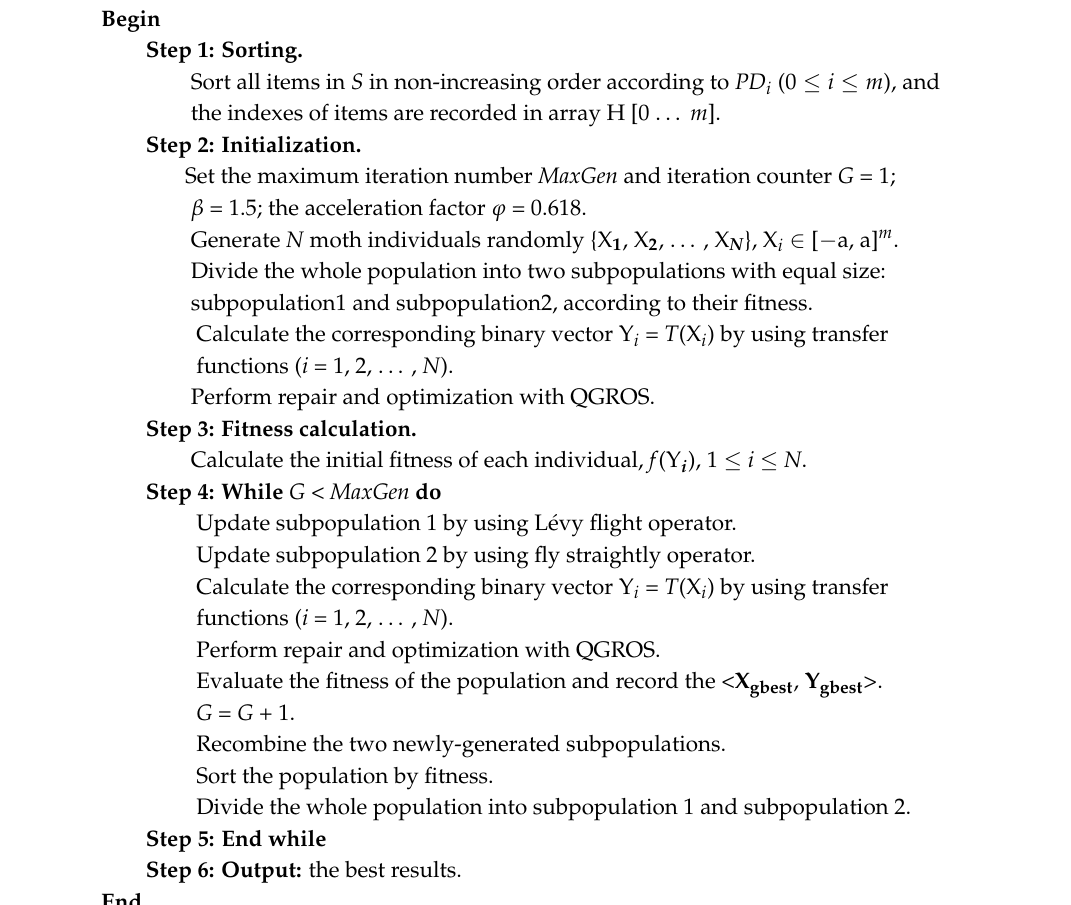
Algorithm 2. The main procedure of discrete MS algorithm for